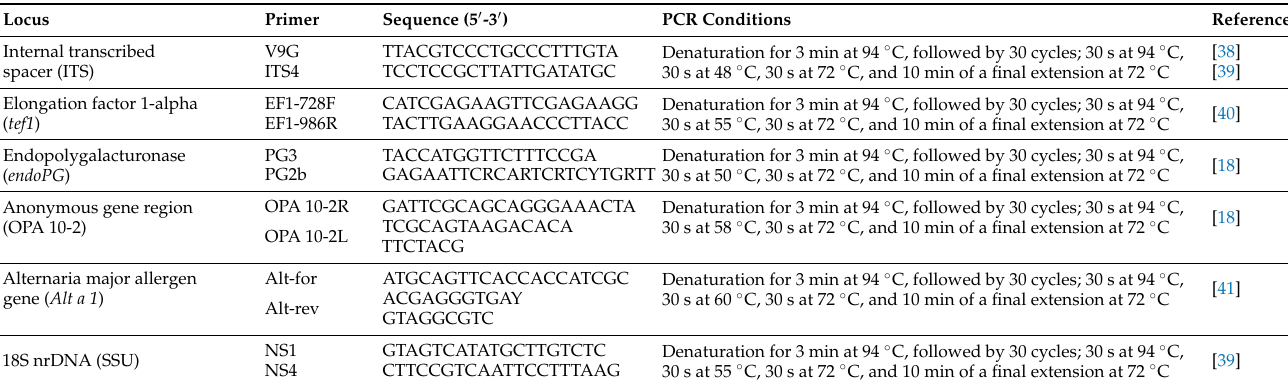
Table 1. List of the primers used for PCR and